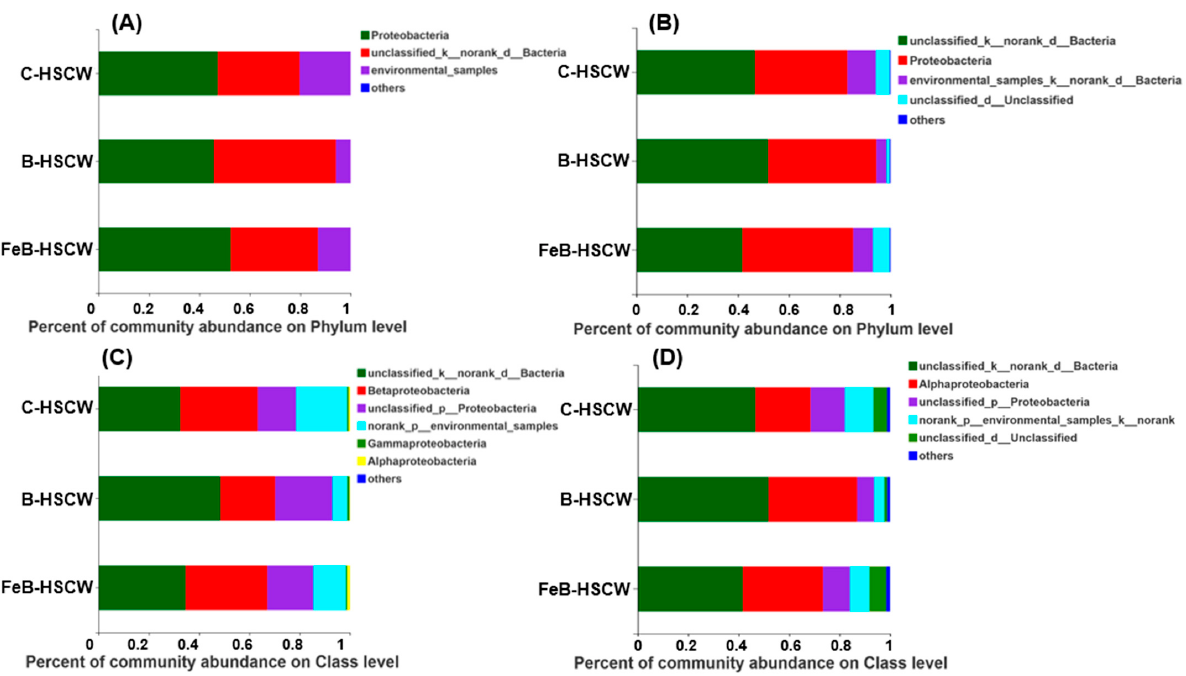
Figure 2. The community structures of nirS -denitrifiers at the phylum level ( A ), nirK -denitrifiers at the phylum level ( B ), nirS -denitrifiers at the class level ( C ), and nirK -denitrifiers at the class level ( D ) in the three constructed wetlands (HSCWs). C-HSCW, without biochar and FeB-modified biochar; B-HSCW, with biochar; FeB-HSCW, with FeB-modified biochar.